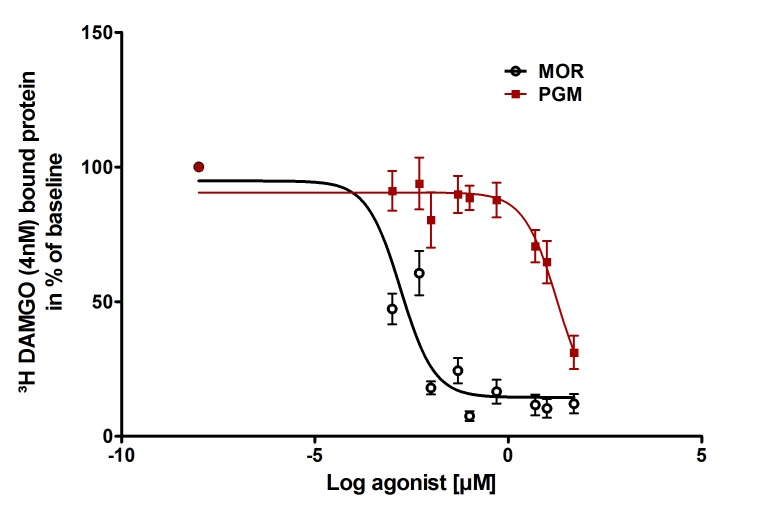
Binding of PG-M and morphine to mu-opioid receptors.Different concentrations of morphine (MOR; circles) or PG-M (squares) were applied to compete with 4 nM [3 hr]-DAMGO binding to mu-opioid receptors stably expressed in HEK 293 cells. The affinity of PG-M was negligible compared to morphine (IC50: 18.7 ± 1.82 µM vs. 0.002 ± 1.37 µM; p<0.001, unpaired t-test); means ± SEM of six independent experiments, each performed in duplicates.DOI:
http://dx.doi.org/10.7554/eLife.27081.01810.7554/eLife.27081.019Figure 10—source data 1.Raw data for Figure 10.Also relates to Figure 9C.